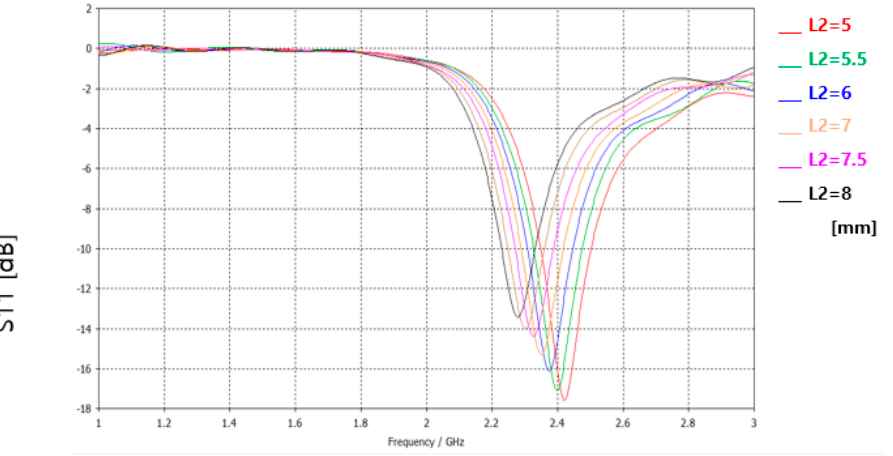
Figure 6. Variation of S11 due to the length of L2.